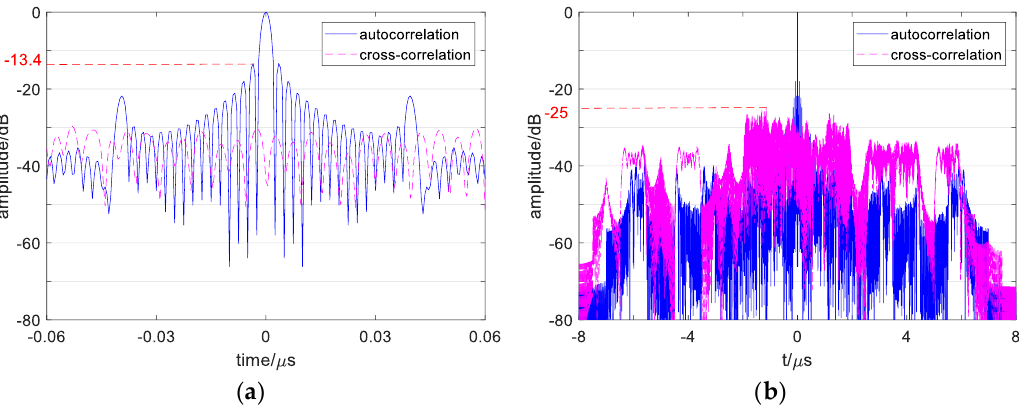
Figure 2. Correlation curve of conventional OFDM chirp signals. ( a ) Correlation curve of s p and s q during − 0.06 µ s ∼ 0.06 µ s . ( b ) Correlation curve of s p and s q during − 8 µ s ∼ 8 µ s